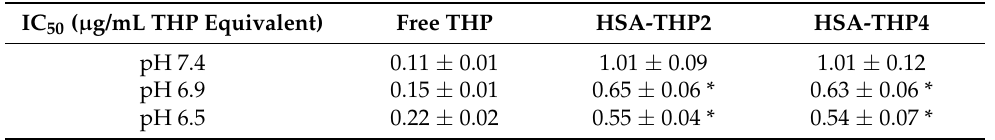
Figure 7. In vitro cytotoxicity of ( a ) free THP, ( b ) HSA-THP2, and ( c ) HSA-THP4 against HeLa cells at different pH values (pH 7.4, pH 6.9, pH 6.5). Cells were treated with THP derivatives for 48 h, followed by an MTS Assay to quantify the numbers of viable cells. Values are the means ± S.E. ( n = 6). Table 1. Half-maximal inhibitory concentration (IC 50 ) values of free THP, HSA-THP2, and HSA-THP4 against HeLa cells after a 48 h drug